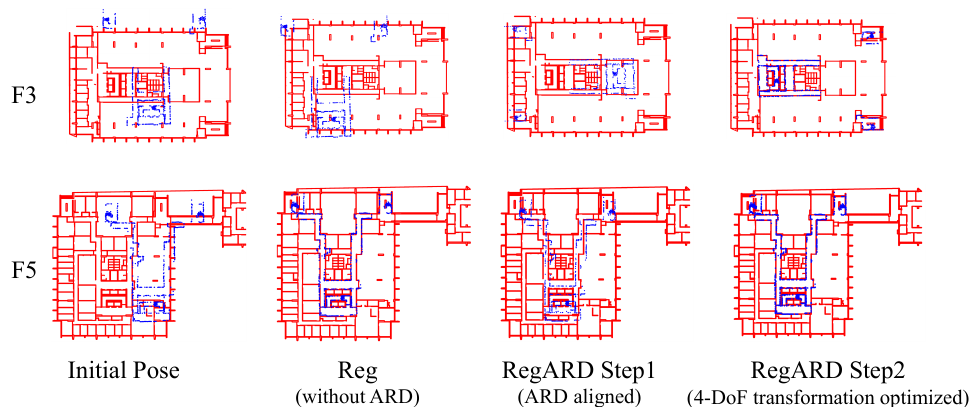
Figure 10. Comparison of registration with and without ARD on F3 and